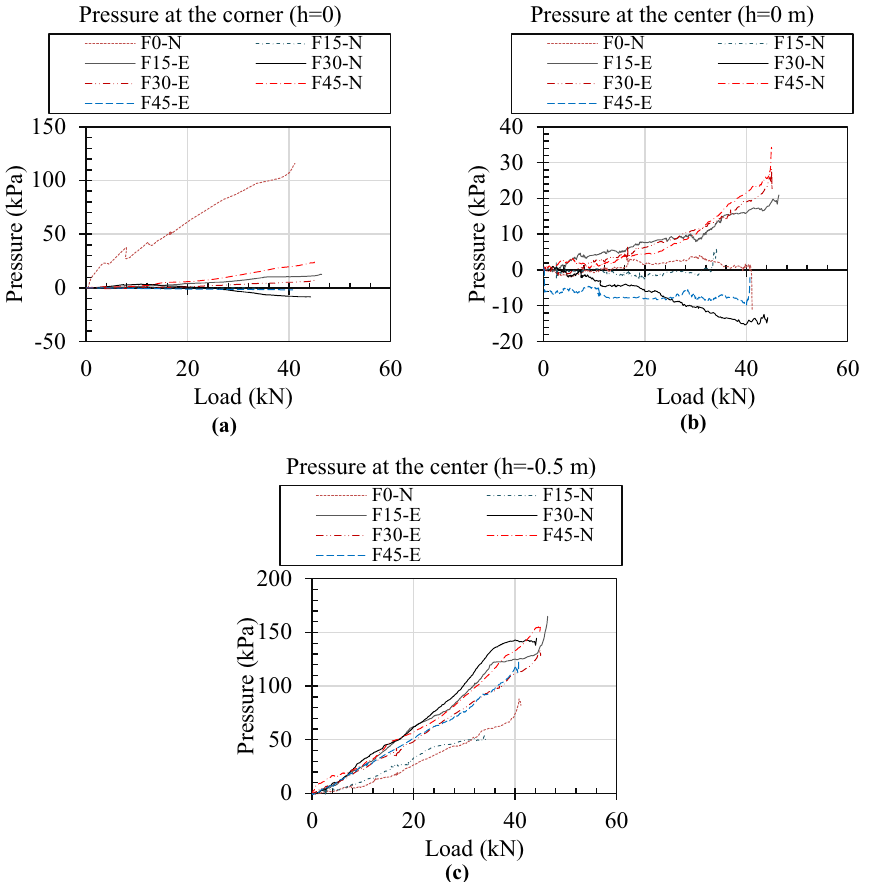
Fig. 15 Load and pressure reading from various pressure cells ( a ) corner cell at h and ( c ) center cell at h